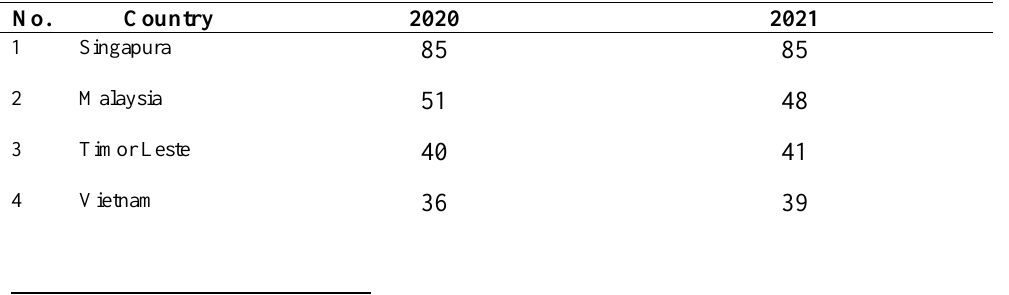
Table 1. Corruption Perception Index of Southeast Asian Countries in 2020 and